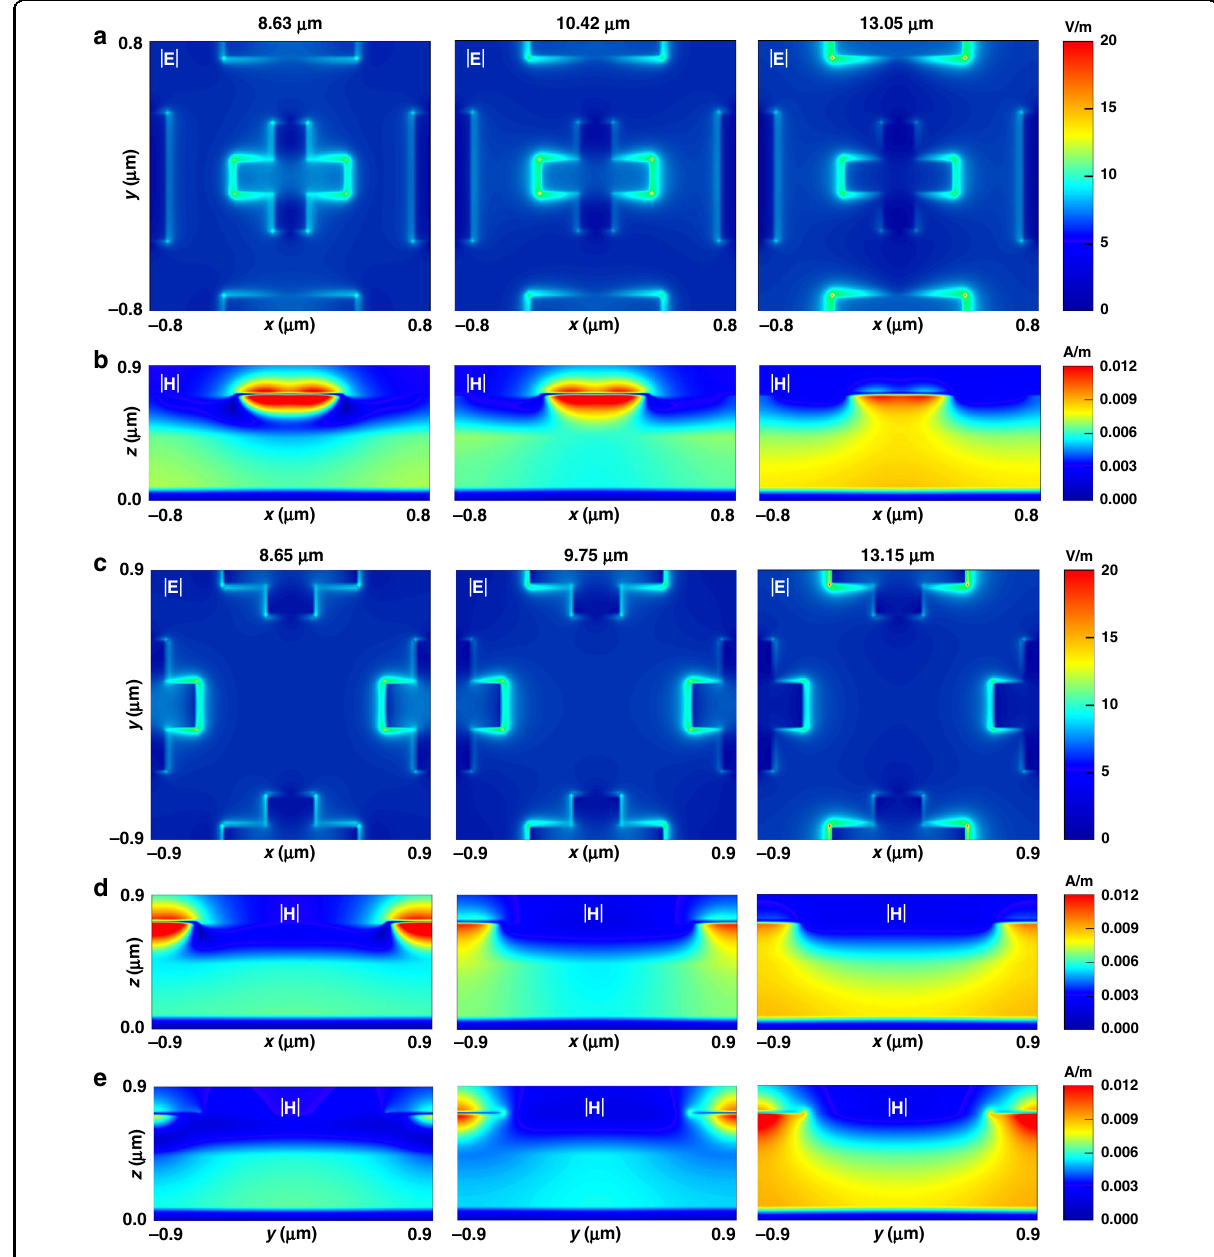
Fig. 4 Electromagnetic fi eld distributions of the two types of Ti/Ge/Si 3 N 4 /Ti absorbers at their three resonant wavelengths along the LWIR range. Ti/Ge/Si 3 N 4 /Ti absorber with periodic nano-cross and nano-strip top metallic resonators: a electric fi eld distributions in the top layer (x-y plane). b Magnetic fi eld distributions in the dielectric (x-z plane, y = 0). Ti/Ge/Si 3 N 4 /Ti absorber with periodic irregular nano-cross top metallic resonators: c electric fi eld distributions in the top layer (x-y plane). d Magnetic fi eld distributions in the dielectric (x-z plane, y = 0). e Magnetic fi eld distributions in the dielectric (y-z plane, x =